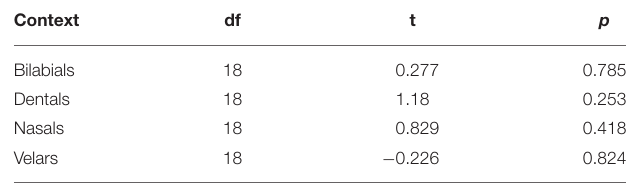
Frontiers in Communication |